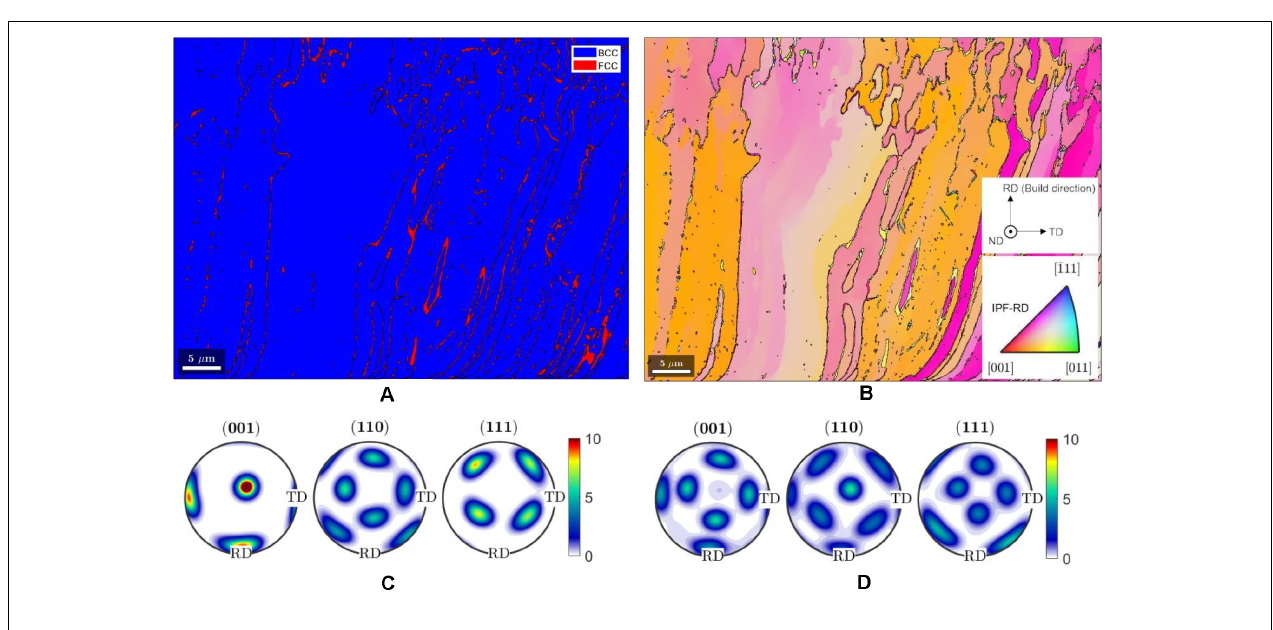
FIGURE 5 | The (A) phase map and (B) IPF-RD map of the AlCrFe 2 Ni 2 LPBF coupon in the as-built condition, obtained by EBSD on a longitudinal section. Build direction is the Rolling Direction (RD). The pole figures with orientation density distribution for the BCC and FCC phase are also included in (C,D) , respectively.